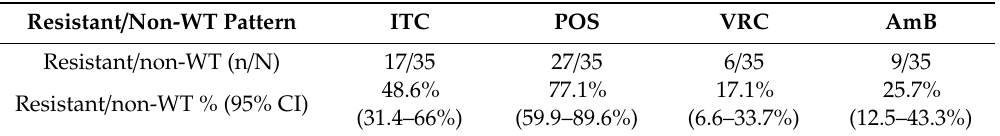
Table 1. Prevalence of resistant / non-wild-type phenotype amongst Aspergillus flavus sensu stricto isolates from the Mekong Delta Region of Vietnam against commonly used anti-fungal agents.